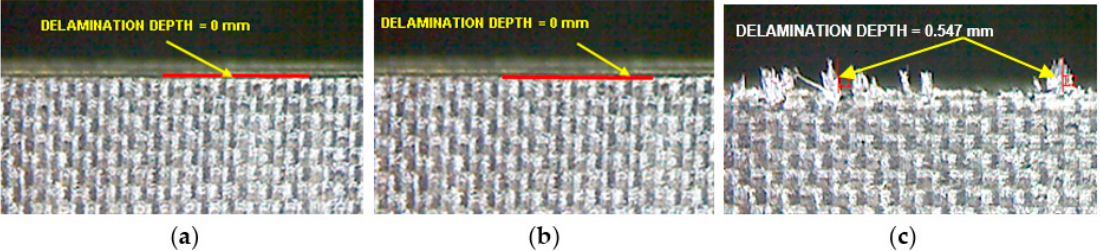
Figure 7. Microscopic images of edges of specimens with delamination depth measured after edge trimming with ( a ) Tool T1; ( b ) Tool T2 and ( c ) Tool T3.